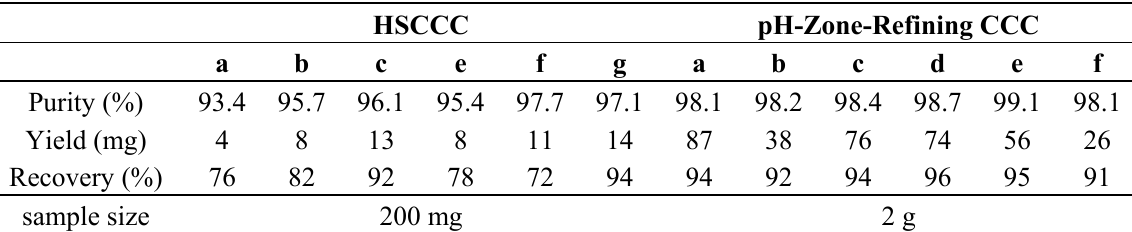
Table 2. Comparison between the two separation